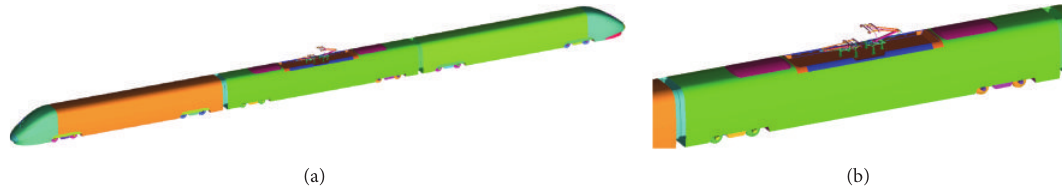
Figure 34: The train model after optimization for aerodynamic noise performance: (a) entire vehicle and (b) magnified view.